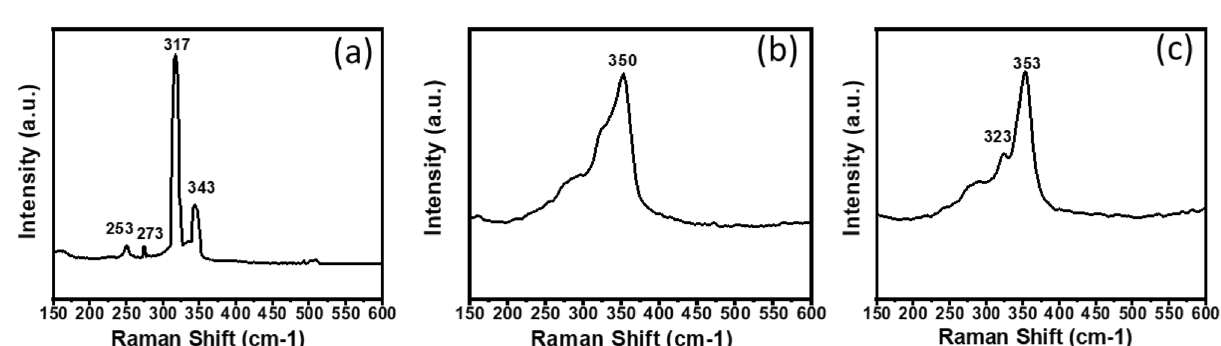
Figure 9. Raman spectra recorded for the AACVD-deposited thin films of Cu 2x Sb 2(1−x) S y where x = ( a ) 0.4 ( b ) 0.6 and ( c ) 0.8. Indicating the presence of ( a ) famatinite (Cu 3 SbS 4 ) and ( b ) and ( c ) tetrahedrite (Cu 12 Sb 4 S 13